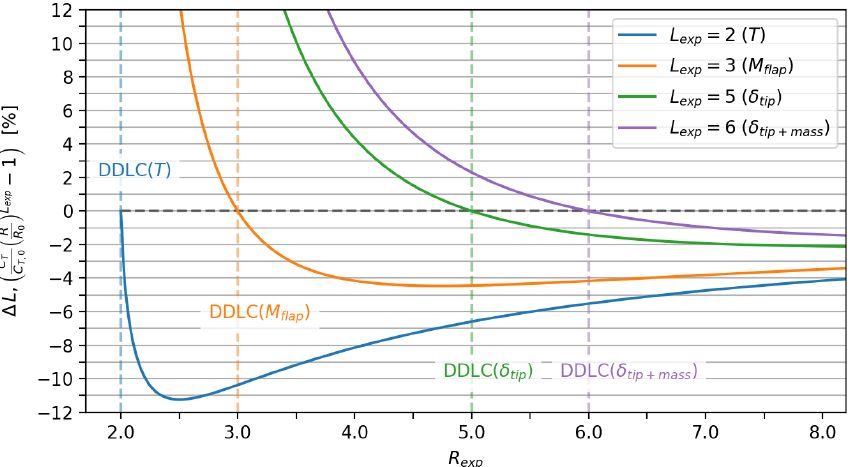
Figure 5. Relative change in different rotor load parameters ( (cid:49) ˜ L ) depending on DDLC. The scaling of loads have the form ˜ L = C T R L exp ; e.g., L exp = 2 scales as the rotor thrust T and L exp = 5 scales as the tip deflection δ tip . Each curve depicts how a load parameter would change depending on the design-driving constraint. As an example, consider a design limited by tip deflection DDLC( δ tip ), i.e., R exp = 5, which matches the dashed green line. Tip deflection meets the requirements, while thrust ( T ) is lowered by 6.6% and flap moment M flap by 4.4%.